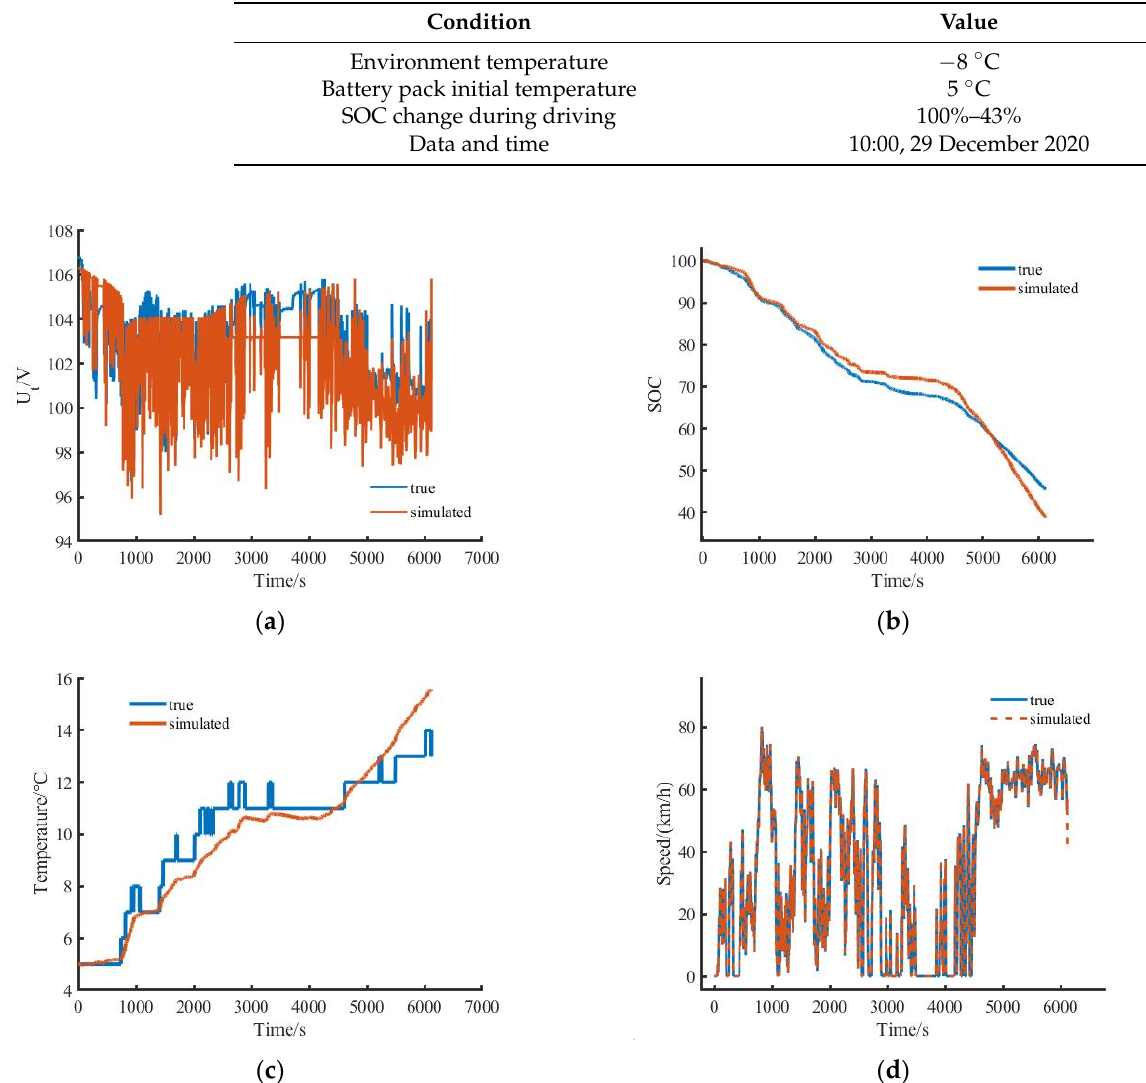
Figure 6. Validating the model and simulation results: ( a ) voltage; ( b ) SOC; ( c ) temperature; and ( d ) speed. Table 2. RMSE of the simulation results.